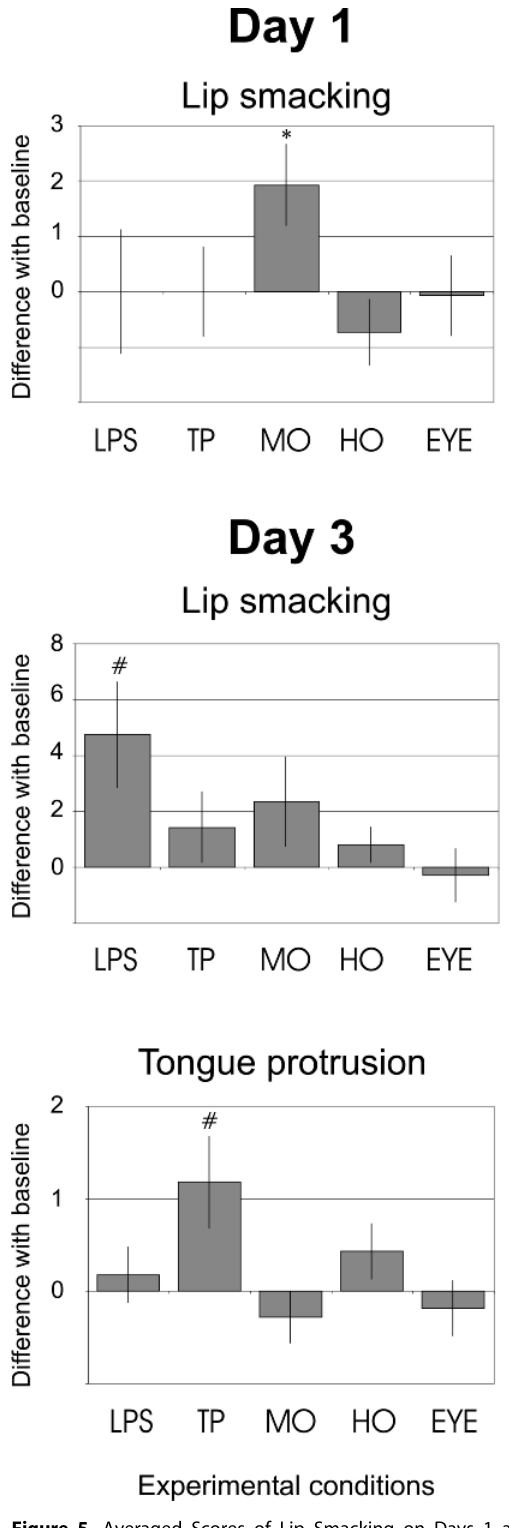
Figure 5. Averaged Scores of Lip Smacking on Days 1 and 3 and of Tongue Protrusion on Day 3 and of the Same Behaviors Scored in the Other Experimental Conditions Averaged scores are calculated as the difference between the frequency of the imitated behavior in the stimulus period and the baseline. The asterisk (*) indicates a significant difference of LPS score in the MO compared with TP and HO conditions. Pound symbols (#) indicate a